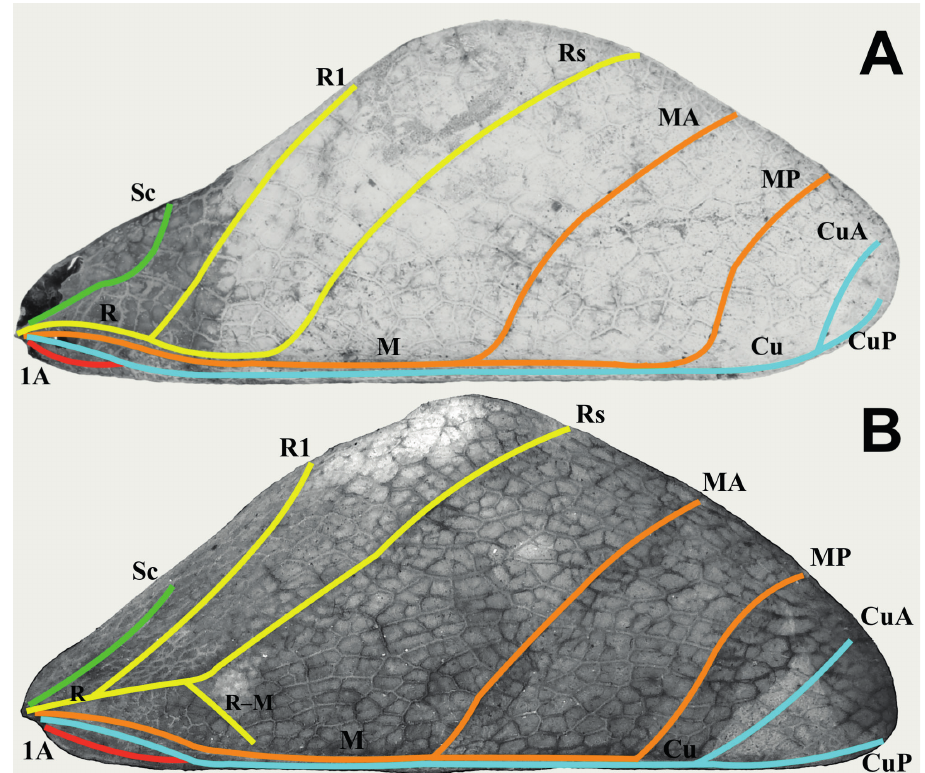
Figure 4. Female tegmina venation for two of the herein described genera A Rakaphyllium schultzei comb. nov. (SDEI) B Vaabonbonphyllium groesseri comb. nov. (SMTD). Abbreviations: Sc (subcosta); R (radius); R1 (radius 1); Rs (radial sector); R–M (radius to media crossvein); M (media); MA (media ante- rior); MP (media posterior); Cu (cubitus); CuA (cubitus anterior); CuP (cubitus posterior); 1A (first